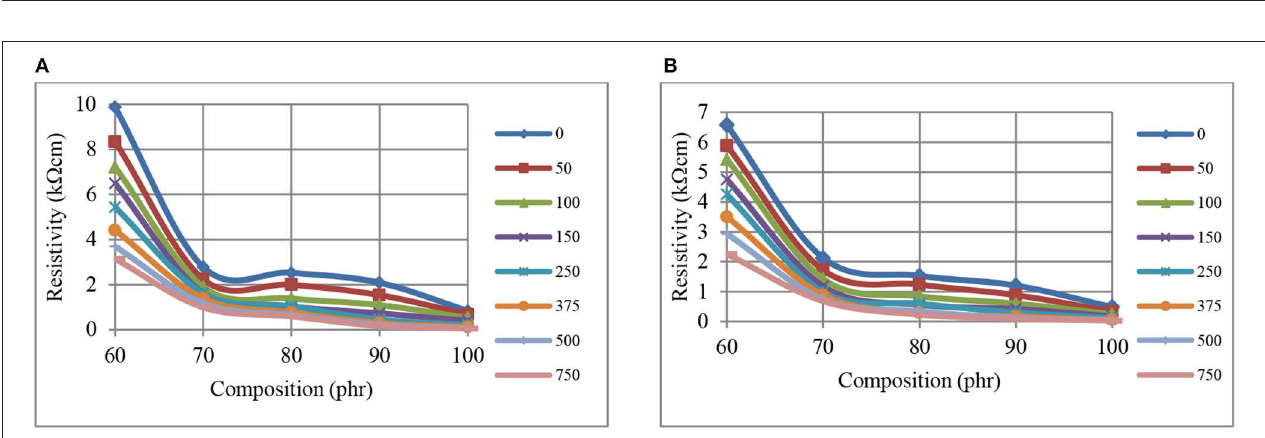
FIGURE 2 | The variation of resistivity, at 1min (A) , and 60min (B) , with composition, for CB-NR composites using different pressures (kPa, inset